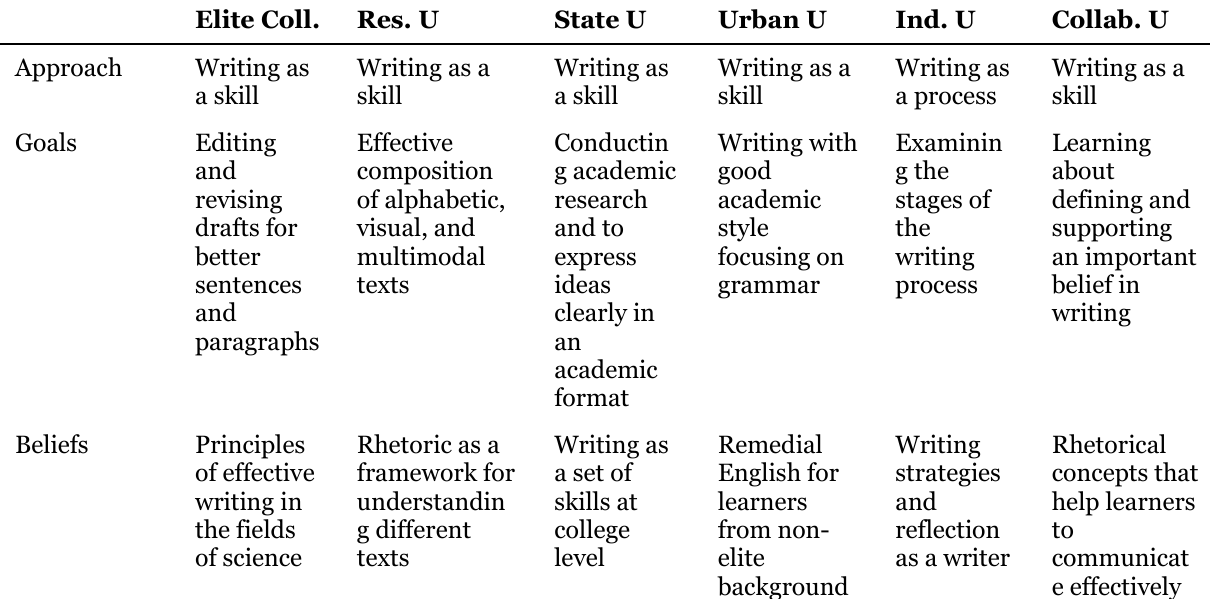
Courses’ Goals, Beliefs, and Assessment for Approaches Elite